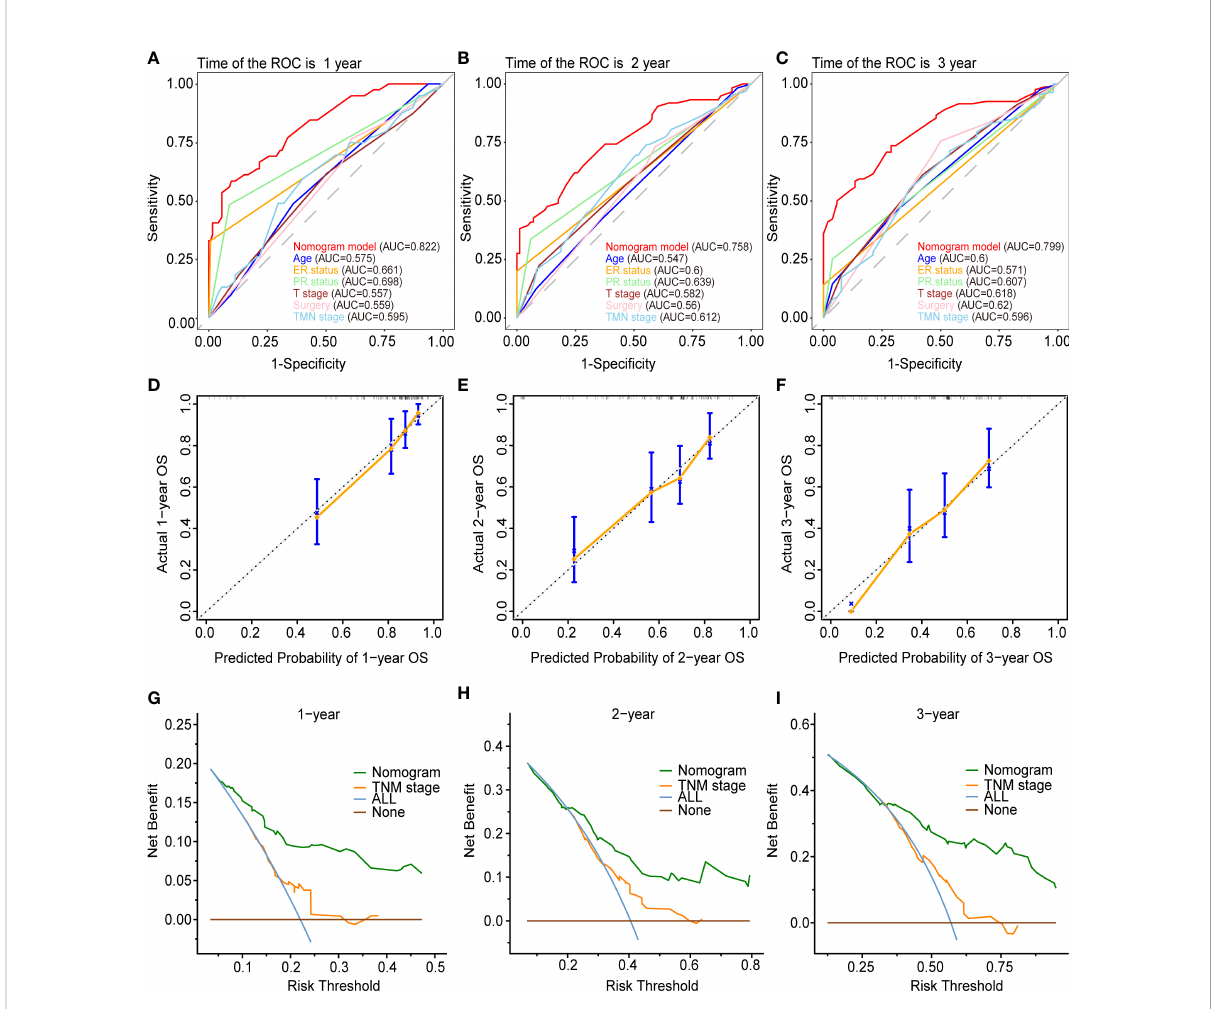
FIGURE 5 Validation of the prognostic nomogram for the 12-,24- and 36months OS. (A – C) The receiver operating characteristic curves (ROC). (D – F) The calibration curves. (G – I) The decision curve analyses